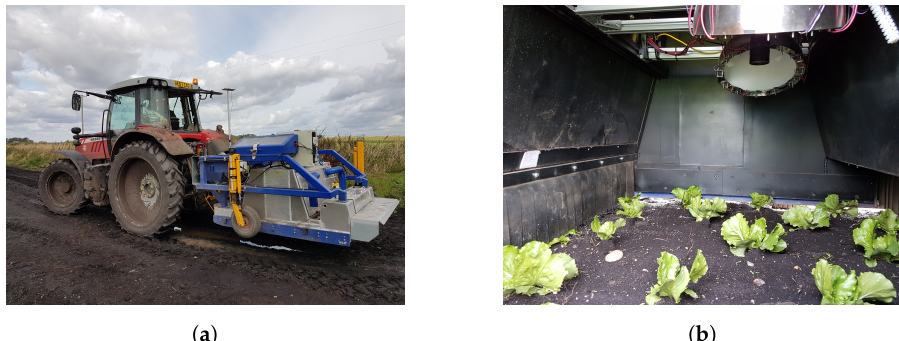
Figure 1. The system in field trials. ( a ) The system mounted to the rear of the tractor. ( b ) The sensor system in-field.